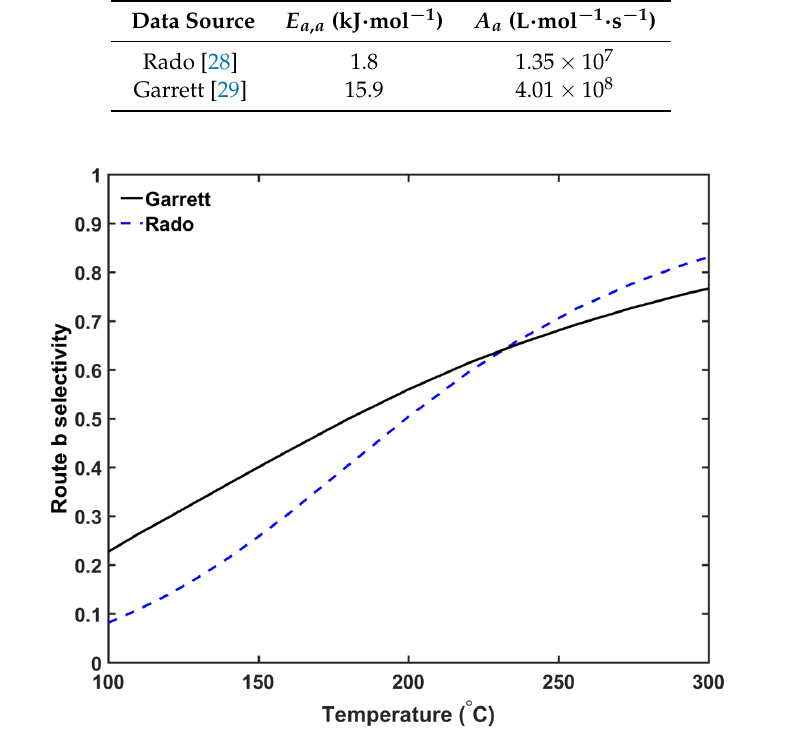
Figure 4. Route b reaction selectivity profile [28,29].